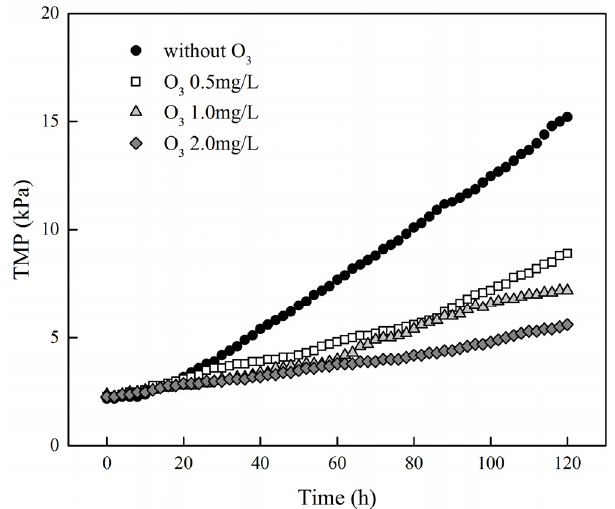
Figure 4. Transmembrane pressure of Mn-Fe-CM under different ozone concentrations in the com- bined process.